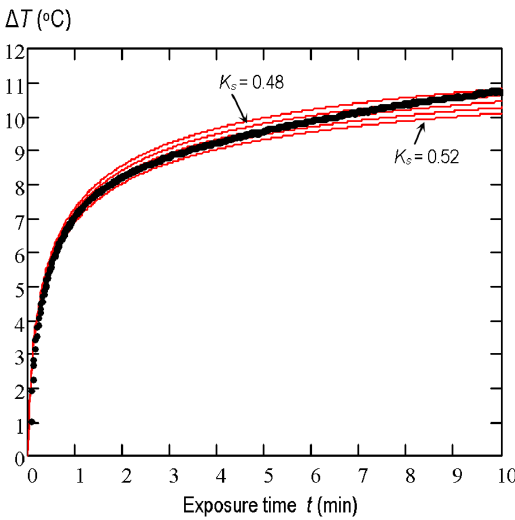
Figure 5. Axial peak-peak pressure variations in the pulsed focused nonlinear sound beam produced in the two-layer system of media (15 mm water/25 mm beef liver) by 20-cycle tone bursts with a 0.2 duty-cycle and calculated for the beams with 3 different average acoustic powers (0.7 W, 1.4 W and 2.1 W).